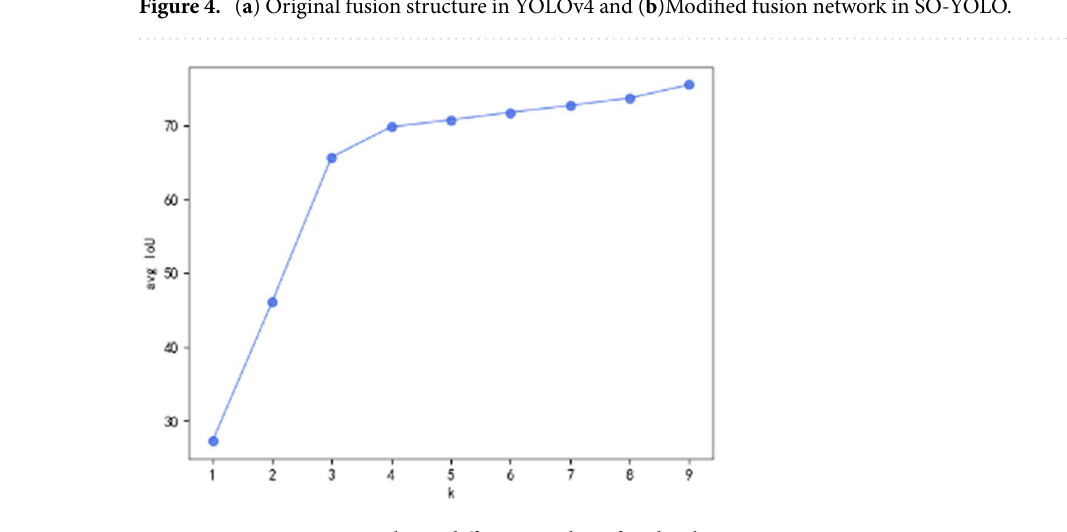
Figure 5. Average IOU results on different number of anchor